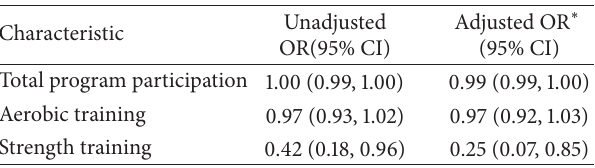
Table 2: Multivariate logistic regression model of factors associated with fall history in an assisted living